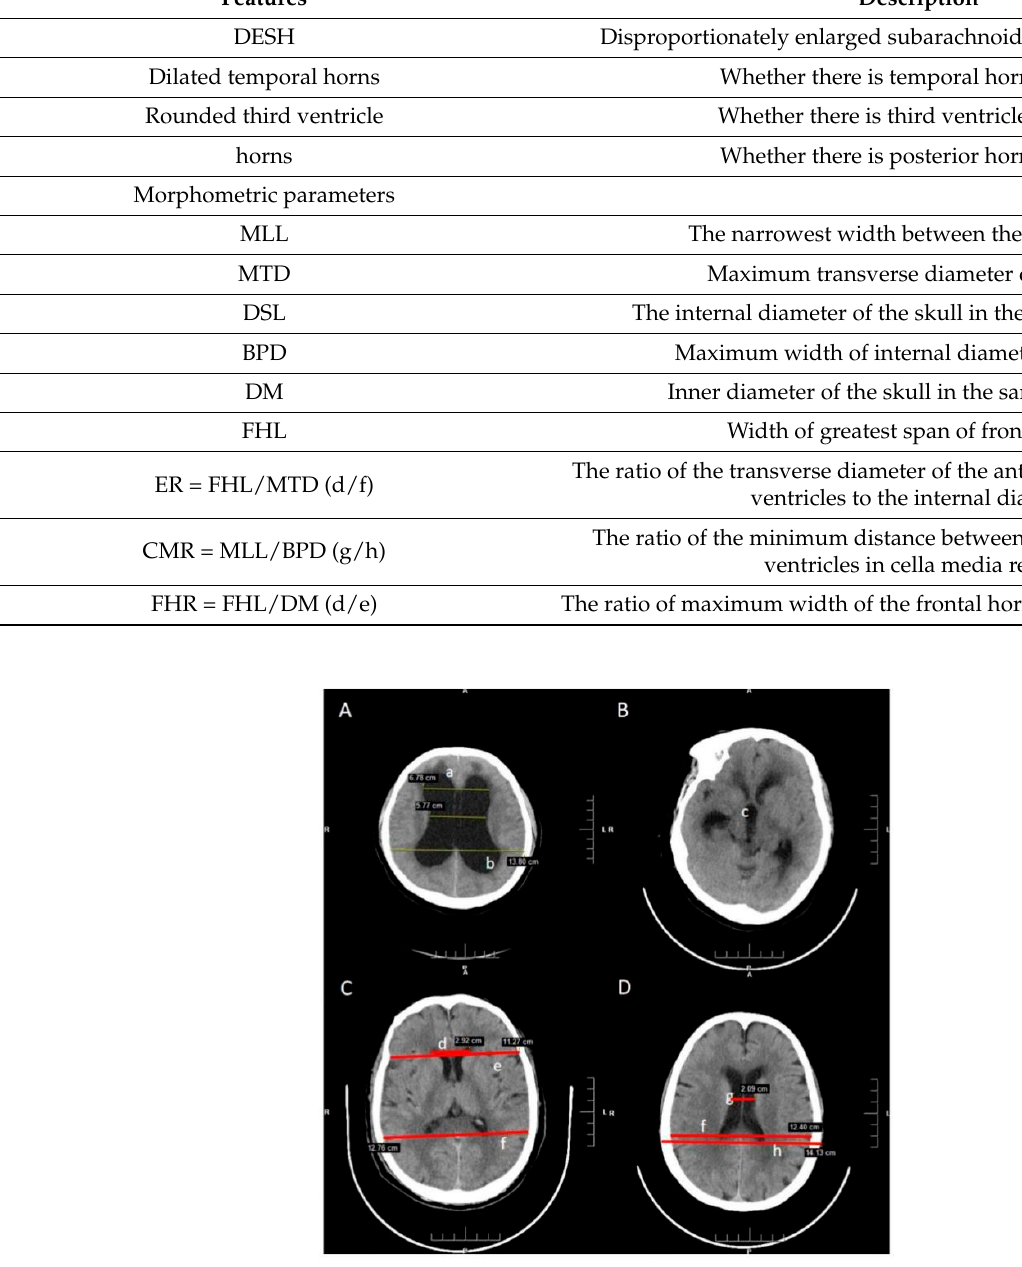
Table 1. The Radiological Features and Morphometric Parameters of CT Image.